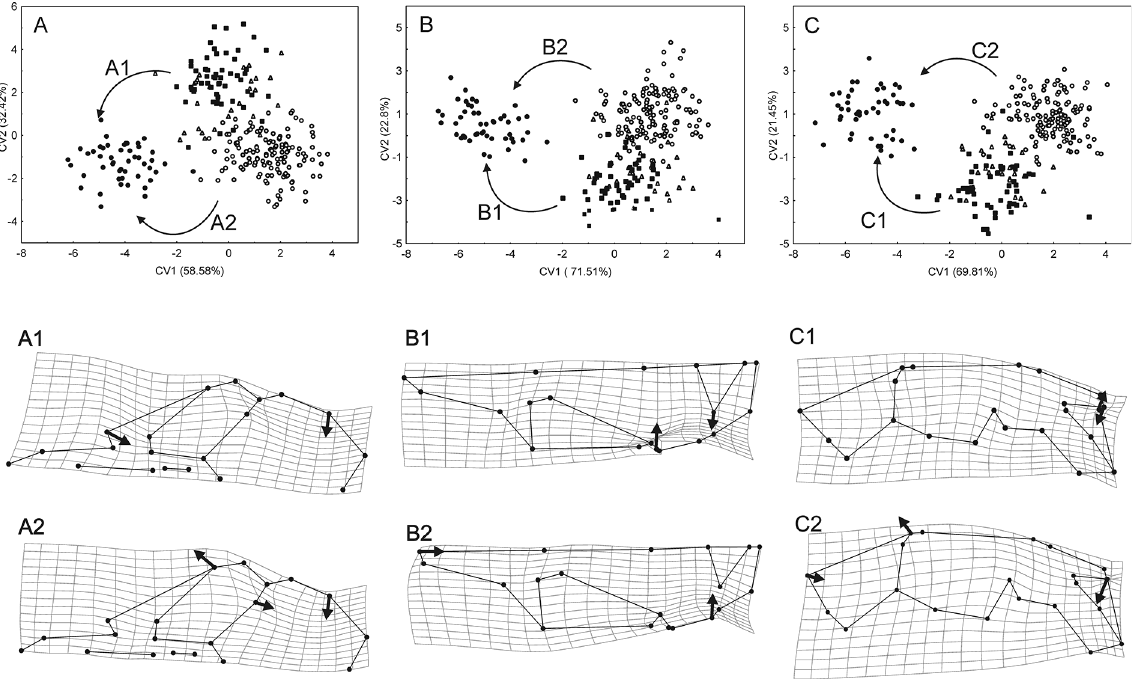
Fig. 7. CVA scatter plot (axes 1 and 2) on shape variables of the (A) ventral, (B) dorsal and (C) lateral side of the Meriones crassus groups (Jeddah group not included). Legends: ○ = Iranian plateau, ● = Western Zagros, Δ = Arabian and ■ = African. Grids show deformation (3 x magnified) when following the trajectory within the morphospace along the arrows and between the groups’ consensus (from African to Western Zagros – A1, B1 and C1; and from Iranian plateau to Western Zagros – A2, B2 and C2). For the numbering of landmarks, see Fig.